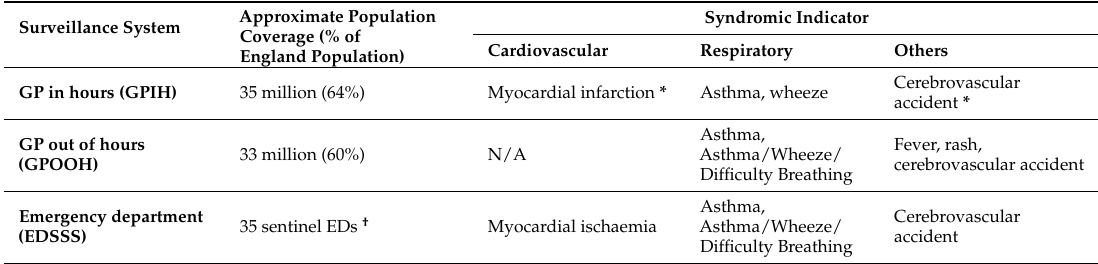
Table 1. Syndromic surveillance systems used in the study and the syndromic indicators included within the